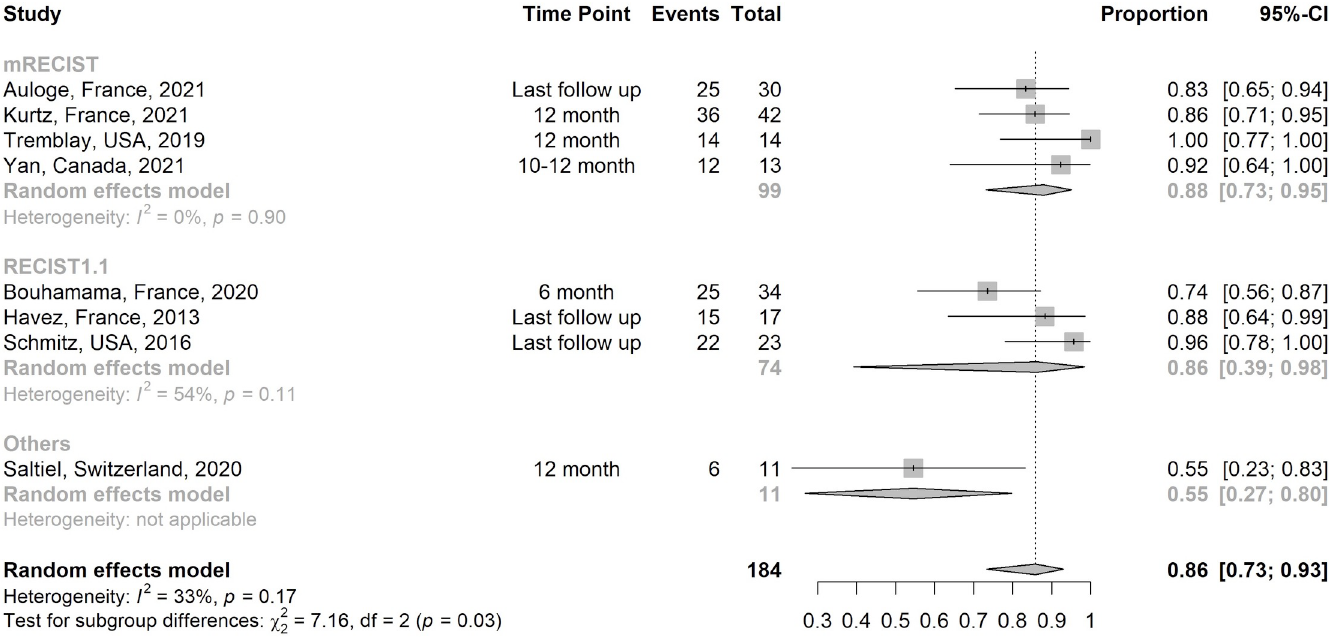
Fig 4. Subgroup analysis of the non-progressive disease rates of all